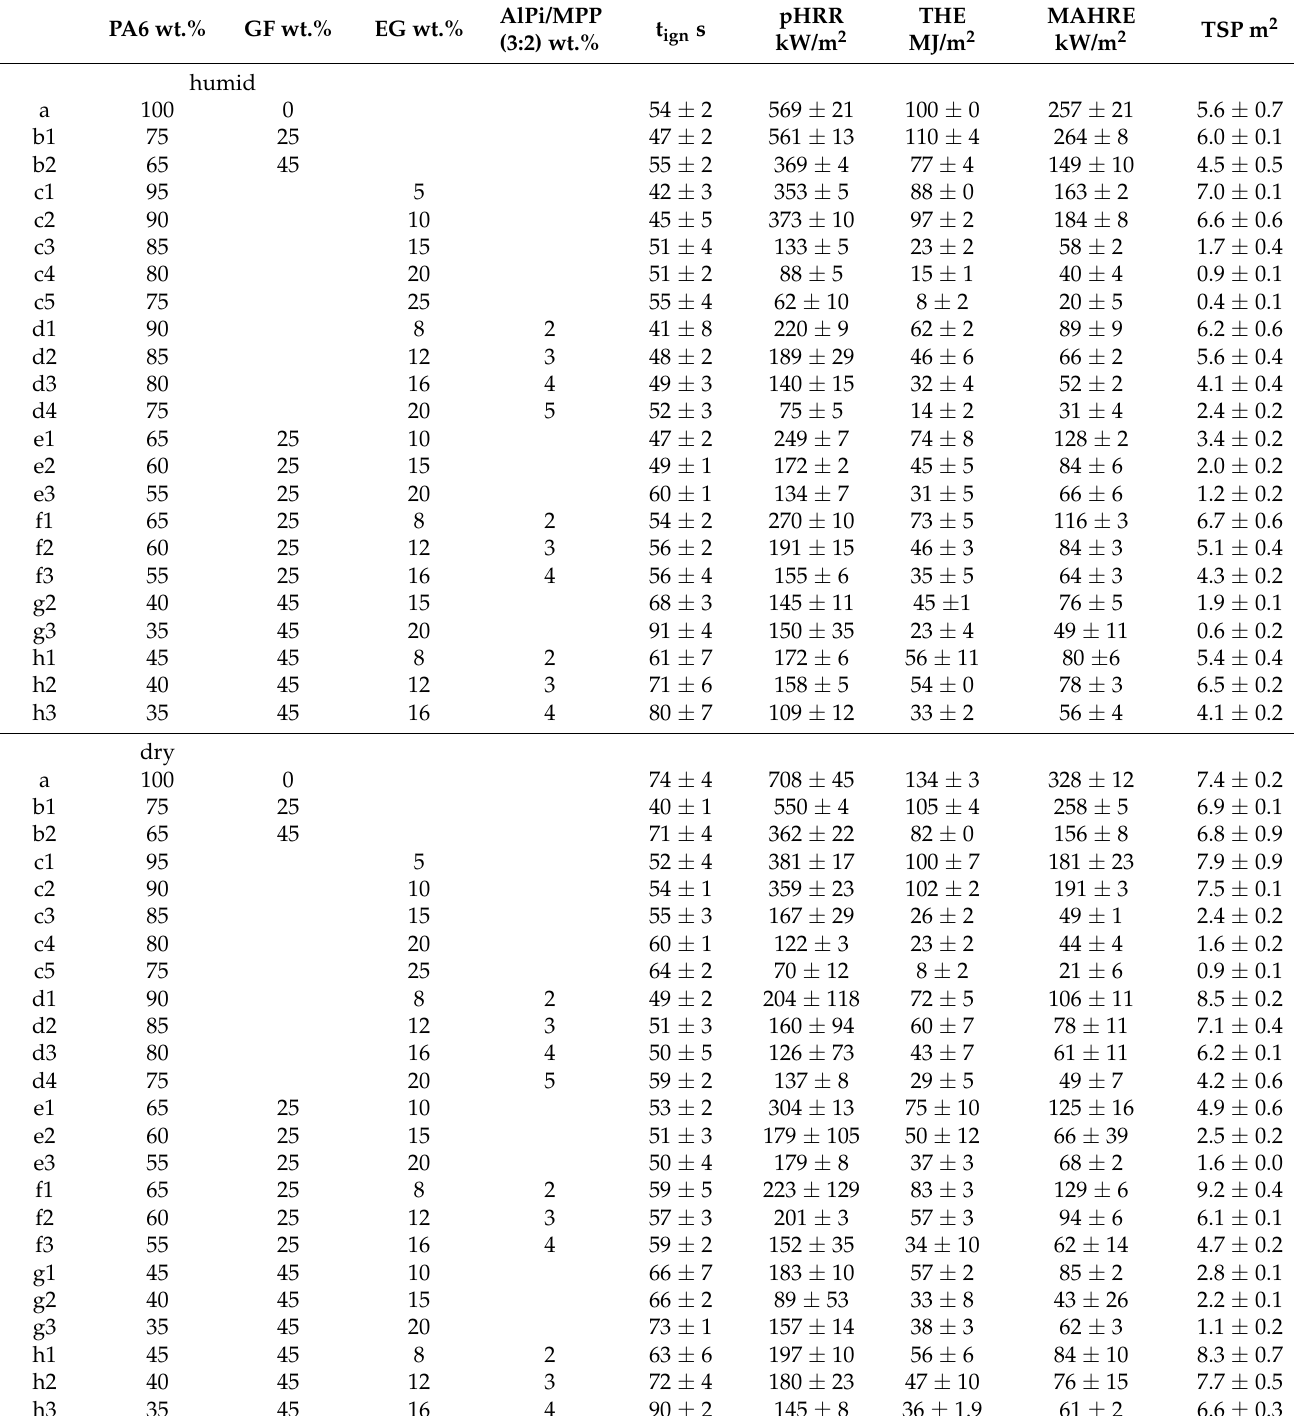
Table 2. Summary of cone calorimeter fire testing results; 50 kW/m 2